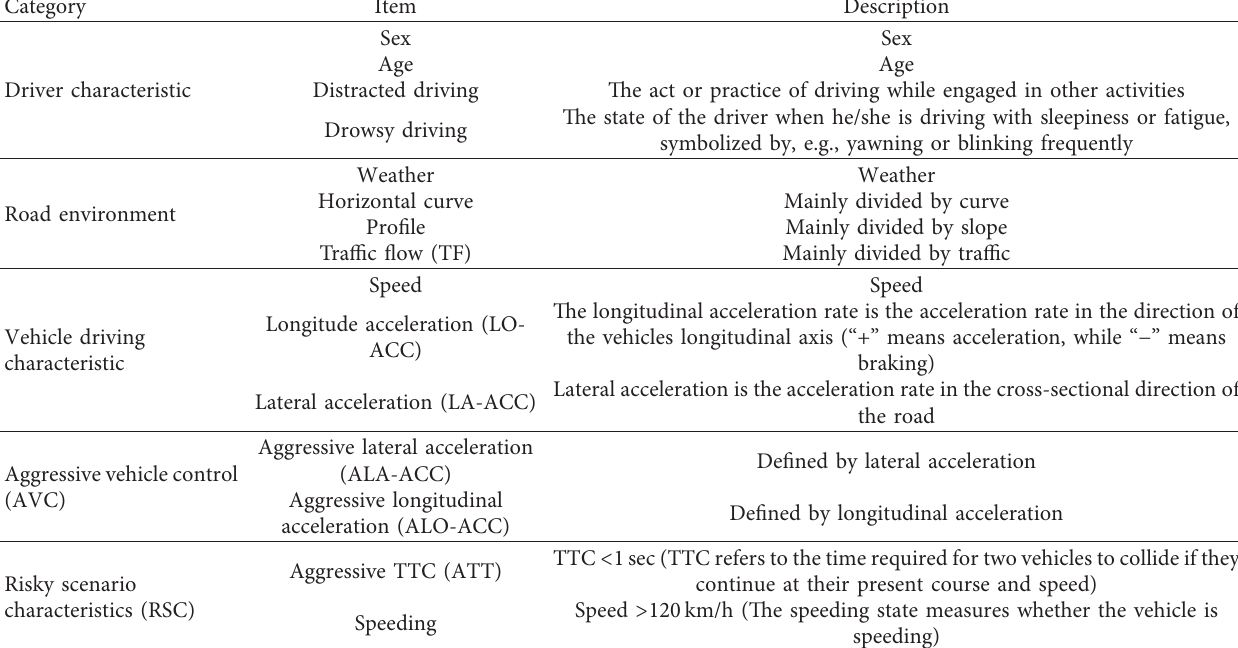
Table 2: Description of